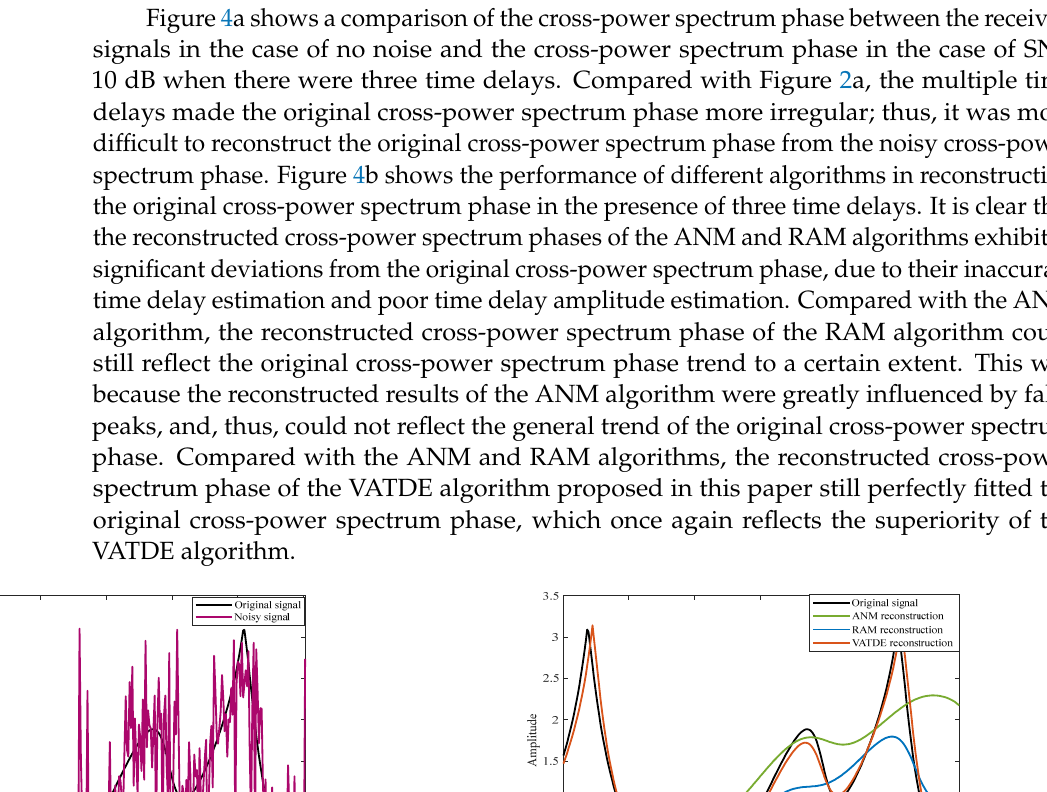
Figure 3. Multiple time delay estimation performance of different algorithms with an SNR of 10 dB.